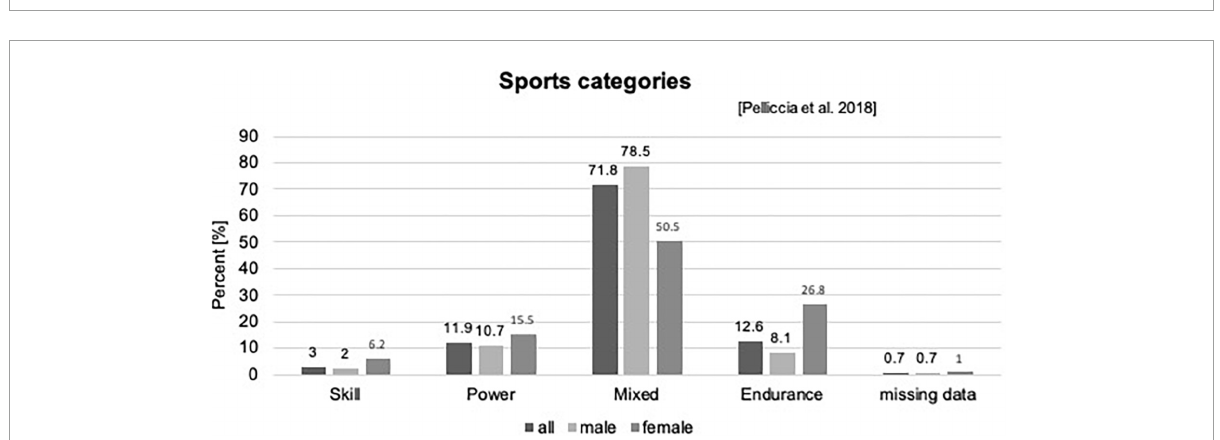
FIGURE1 Study flow chart.